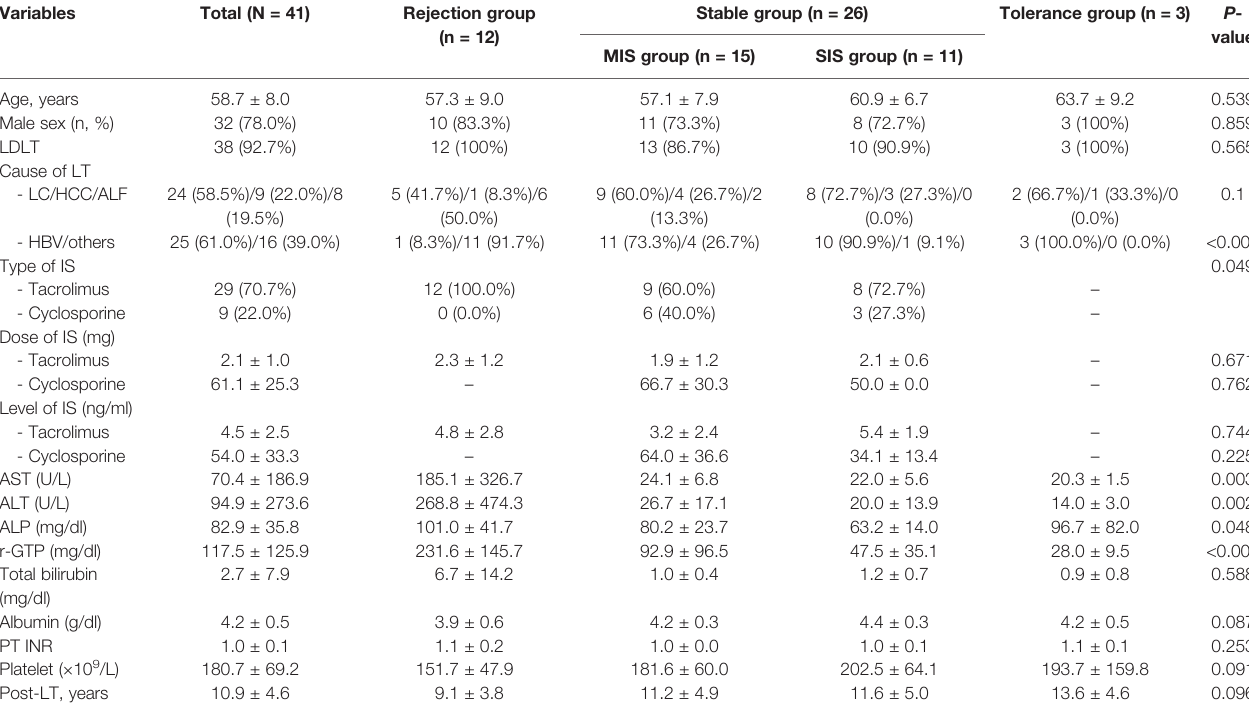
TABLE 1 | Baseline characteristics of the entire